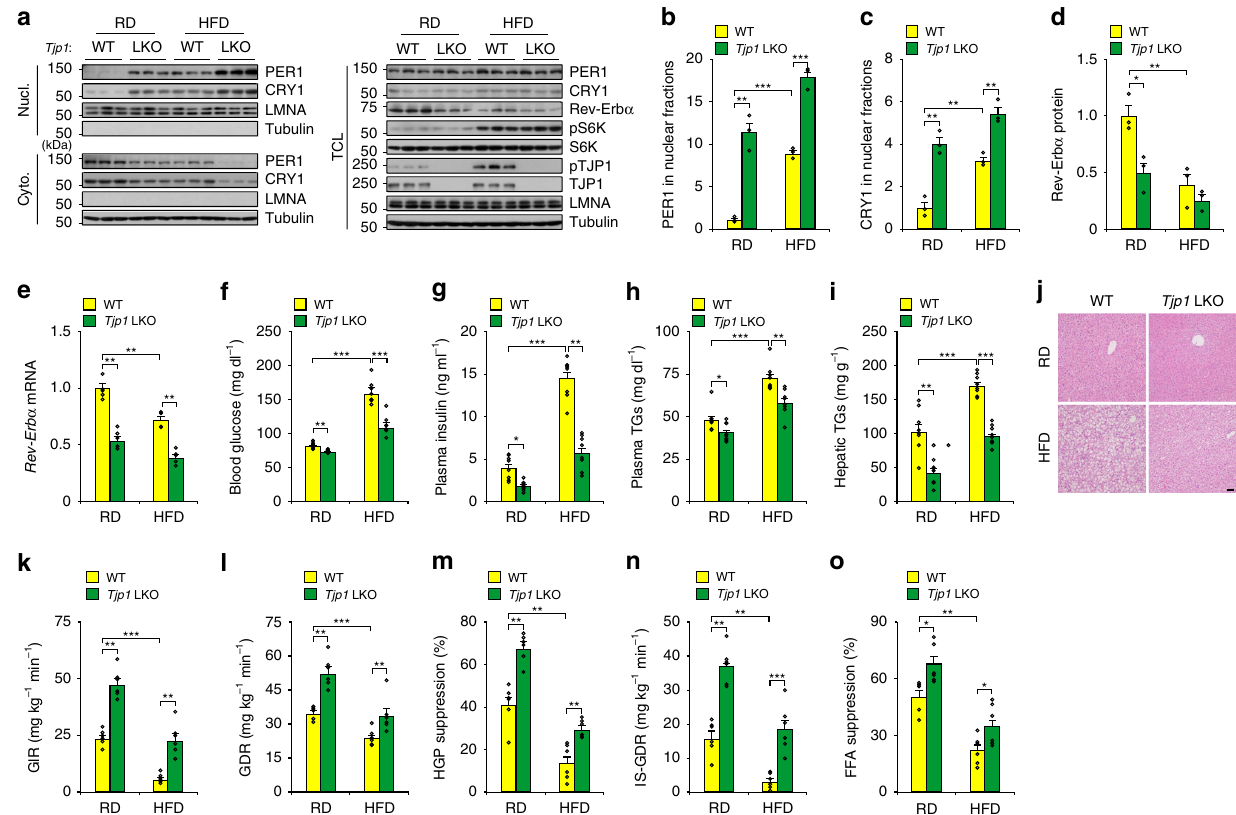
Fig. 7 TJP1 de fi ciency enhances insulin sensitivity. a – e Effect of Tjp1 LKO on nuclear PER1 levels evaluated by immunoblots a , statistical analysis of PER1 b , and CRY1 c in Nucl., statistical analysis of Rev-Erb α in TCL d , and Rev-Erb α expression e in liver extracts from mice fed on a RD or HFD for 16 weeks. n = 5 mice. f – i Effect of Tjp1 LKO on blood glucose f , plasma insulin levels g , plasma triglyceride levels h and hepatic triglyceride contents i from mice fed on a RD or HFD for 16 weeks. TGs triglycerides. n = 8 mice. j Hematoxylin and eosin staining of liver from WT and Tjp1 LKO mice fed on a RD or HFD for 16 weeks. Scale bar, 50 μ m. k – o Glucose infusion rate (GIR, k ), glucose disposal rate (GDR, l ), percentage suppression of HGP m , insulin-stimulated GDR (IS-GDR, n ) and percentage of free fatty acid (FFA) suppression o from WT and Tjp1 LKO mice fed on a RD or HFD for 16 weeks. n = 6 mice. Data are shown as mean ± s.e.m. Comparison of different groups was carried out using two-way ANOVA. *P < 0.05, **P < 0.01, ***P < 0.001. Source data are provided as a Source Data fi le.